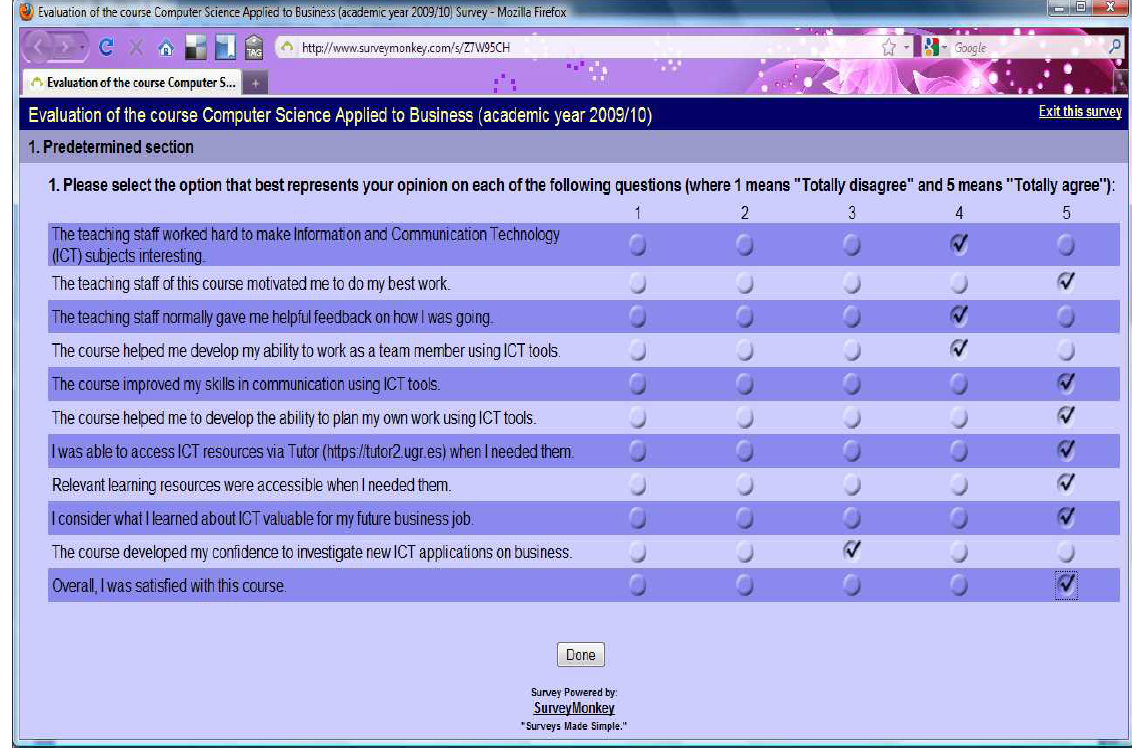
Fig 3. Example of questionnaire ( R 1